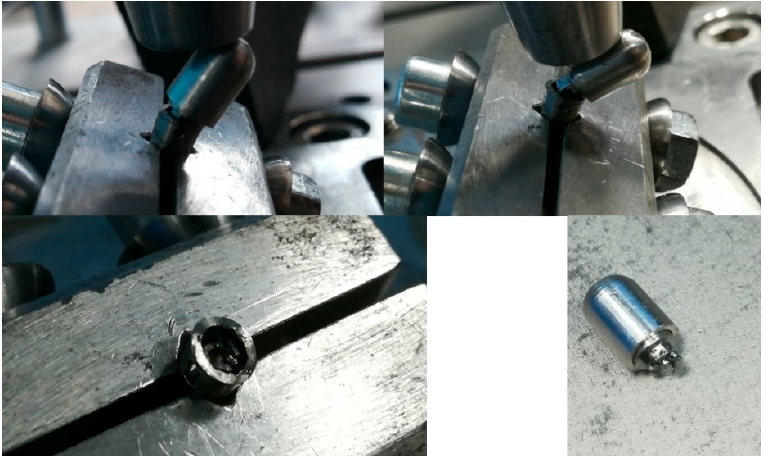
Figure 17. Failure of third implant during fatigue testing .